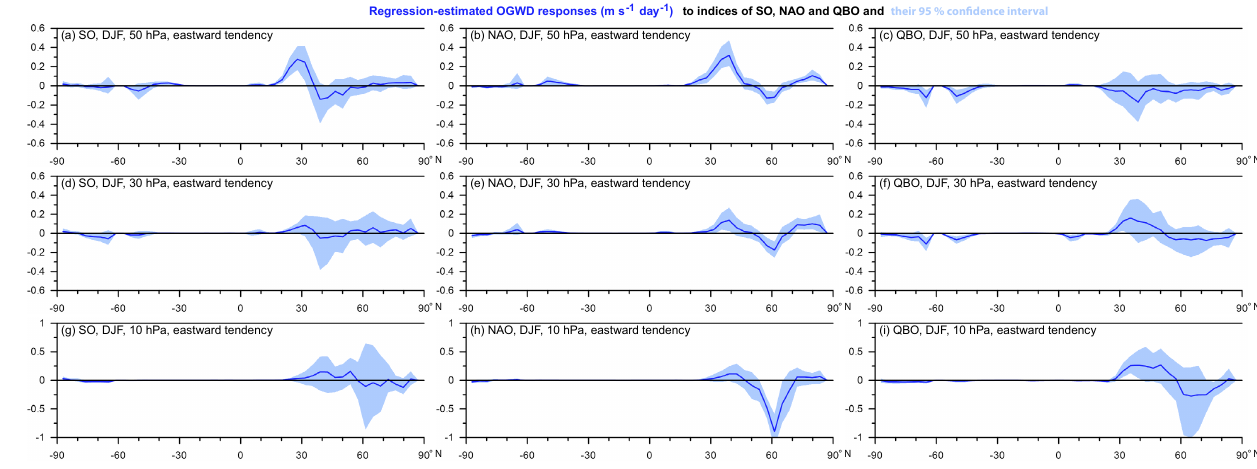
Figure 5. Response of the zonal-mean OGWD (ms − 1 day − 1 ) at the 50hPa (a, b, c) , 30hPa (d, e, f) and 10hPa (g, h, i) level related to the activity of the Southern Oscillation (a, d, g) , North Atlantic Oscillation (b, e, h) and quasi-biennial oscillation (c, f, i) . The responses correspond to the increase in the oscillation index by 4 times its SD, i.e., to the transition of the respective oscillation from a highly negative to a highly positive phase; the blue curve shows the signal value and blue shading illustrates the 95% confidence interval. Analysis period: 1979–2010, monthly data, DJF season.